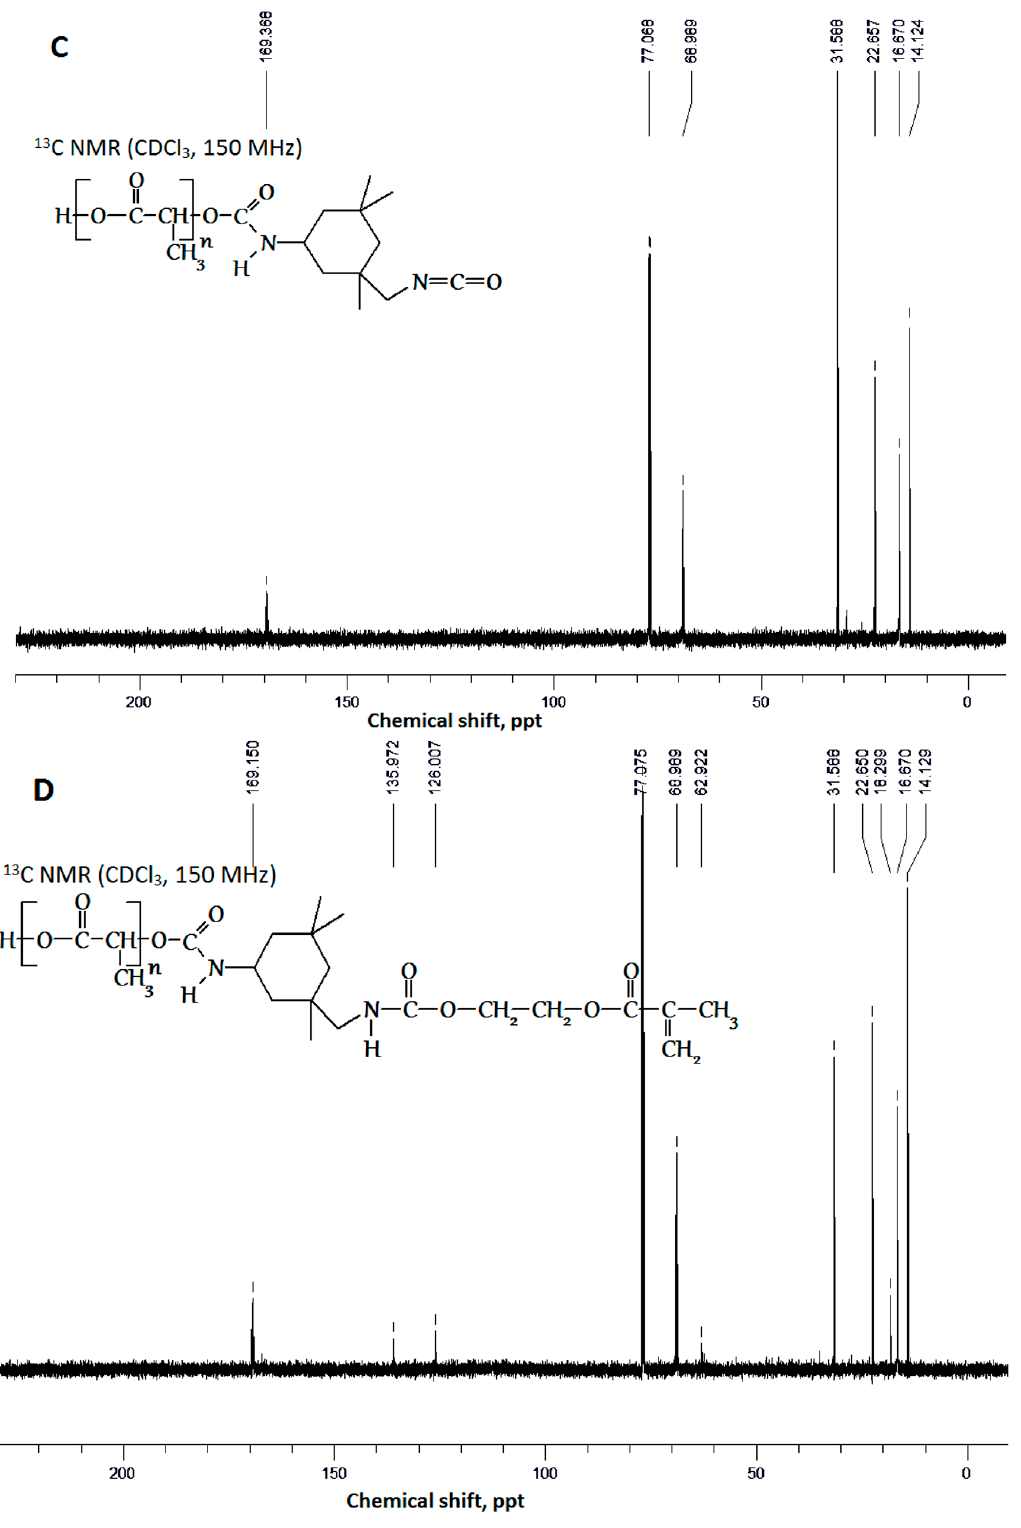
Figure 10. ( A ) The 1 H-NMR spectrum of the PLA isocyanate derivative, obtained at the first stage. ( B ) The 1 H-NMR spectrum of the PLA methacrylate derivative, obtained at the second stage. ( C ) The 13 C-NMR spectrum of the PLA isocyanate derivative, obtained at the first stage. ( D ) The 13 C-NMR spectrum of the PLA methacrylate derivative, obtained at the second stage.